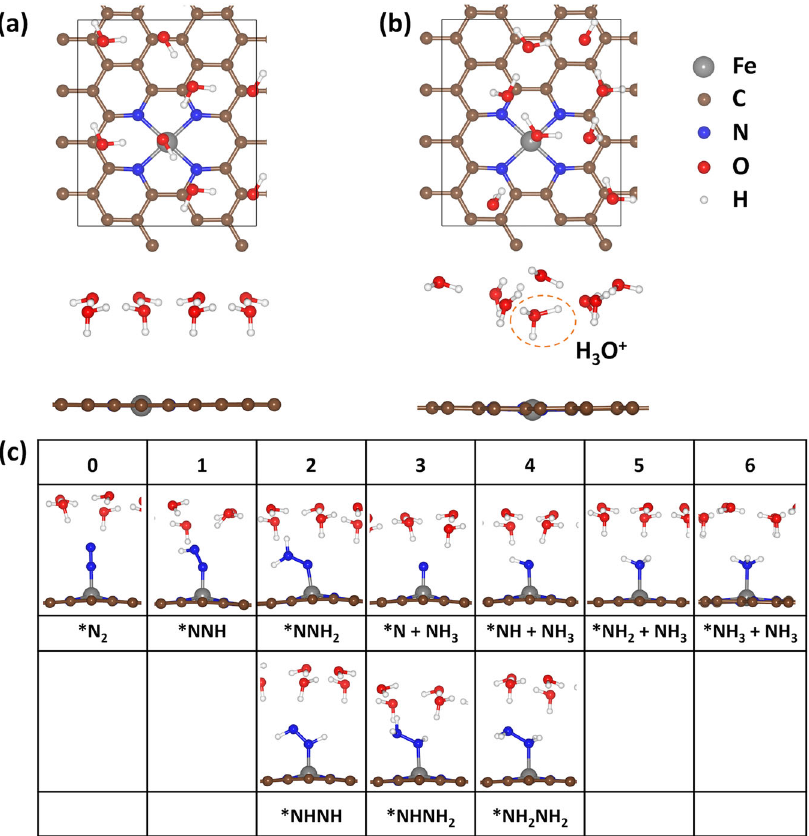
Fig. 2 Calculation models for Fe@N 4 catalysts. Fe@N 4 with a a hexagonal ice bilayer water and b a hexagonal ice bilayer water containing a solvated H 3 O + . Top view and side view are shown in the upper panel and lower panel, respectively. c The optimized geometries of all possible reaction intermediates of NRR. The number of transferred protons is listed in the fi rst row. For *NH + NH 3 , *NH 2 + NH 3 , and *NH 3 + NH 3 , the liberating NH 3 is omitted for the